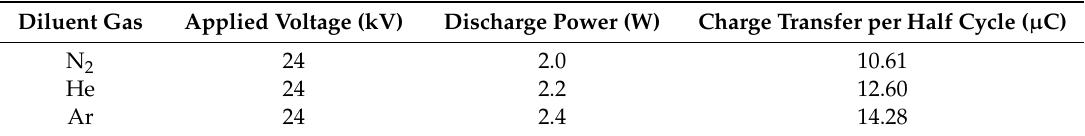
Figure 2. Lissajous figure for different diluent gases at constant applied voltage 24 kV (Flow rate 30 Table 1. Discharge characteristics at different diluent gases.